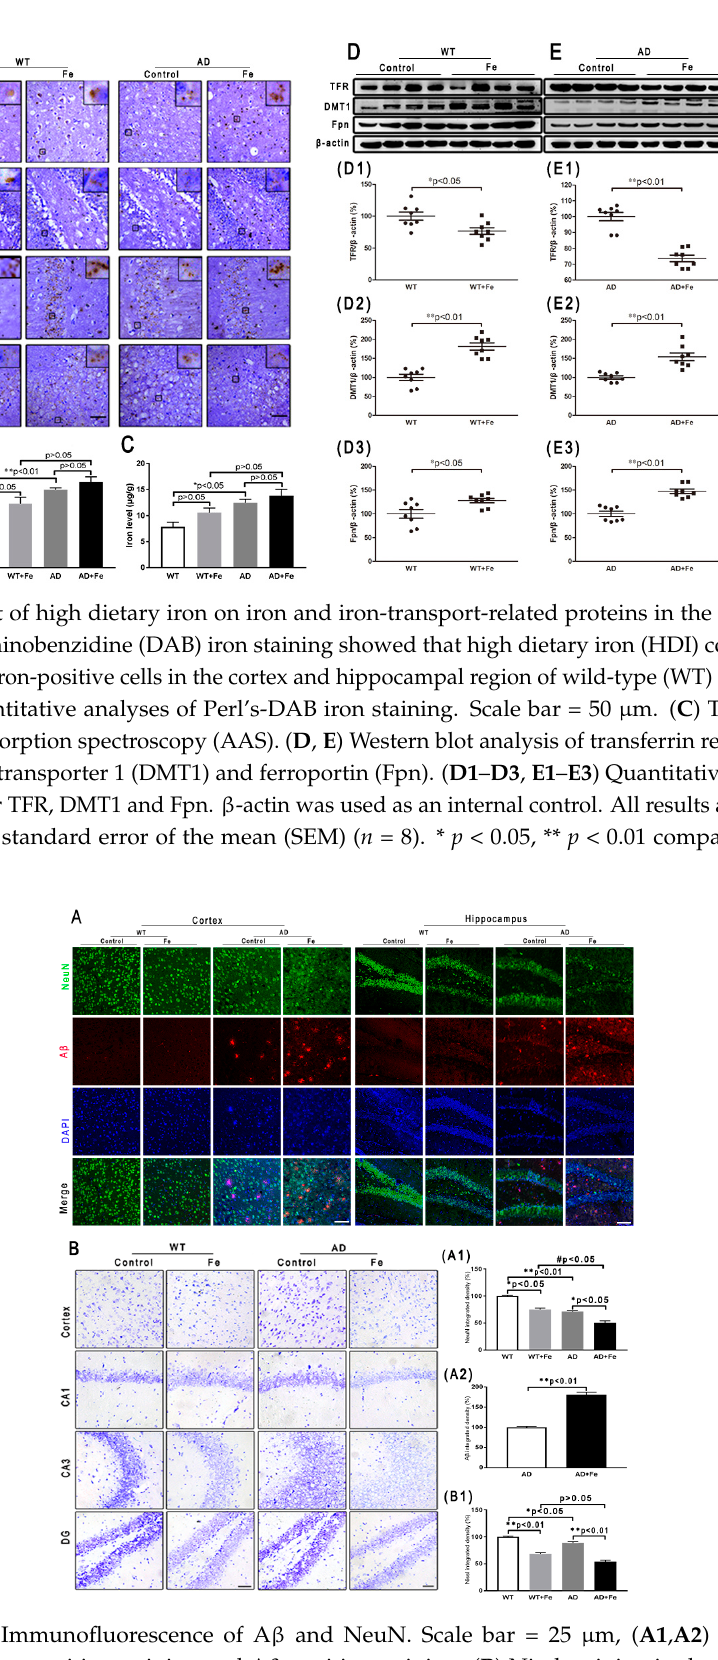
Figure 1. Effect of high dietary iron on iron and iron-transport-related proteins in the mouse brain. ( A ) Perl’s diaminobenzidine (DAB) iron staining showed that high dietary iron (HDI) could increase